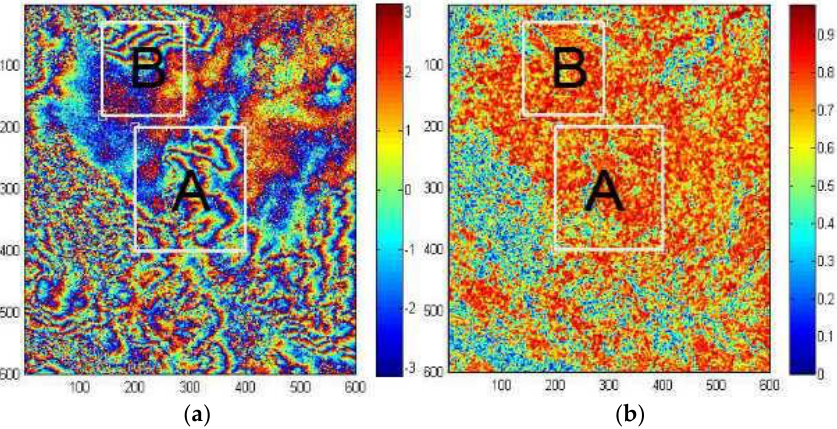
Figure 10. ( a ) Original interferogram; and ( b ) corresponding coherence map over Hong Kong. A and B, labeled by white rectangles, indicates the enlarged areas.